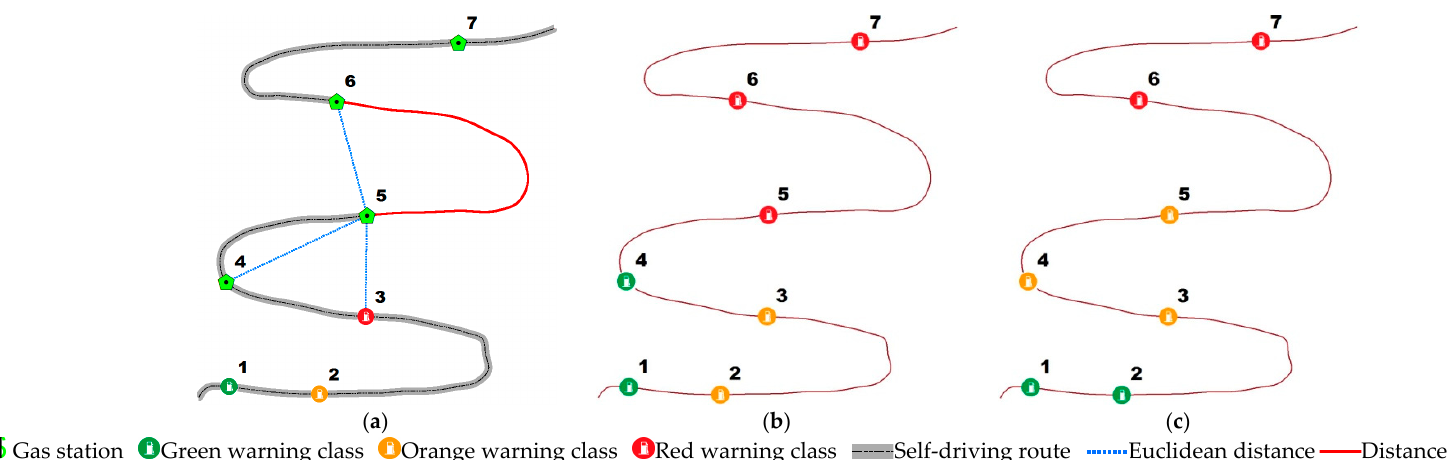
Figure 6. The impact sensitivity analysis of clustering attribute changes on clustering results. ( a ) Hypothetical gas station layout under complex road conditions; ( b ) calculation result based on Euclidean-distance and mixed-distance clustering attributes; ( c ) calculation result based on the distance between the gas station and the starting point as a clustering attribute.